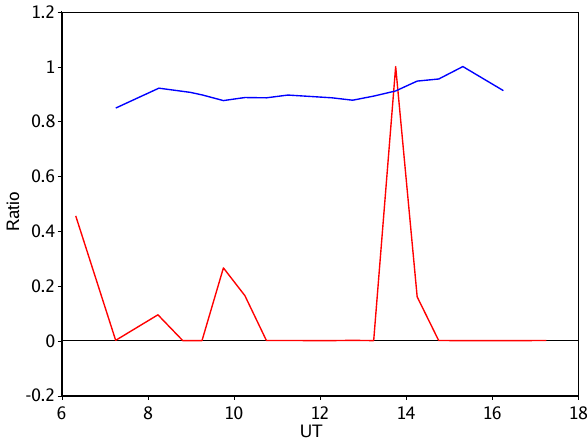
Fig. 1. Ratio of the observed and expected irradiance for a cloudless (5 August 2007; in blue) and for a cloudy (20 July 2008; in red) day at Uccle. The points that appear as null values are points for which the ratio is very small. This can be explained by the influence of clouds, which causes the observed irradiance to be very low.